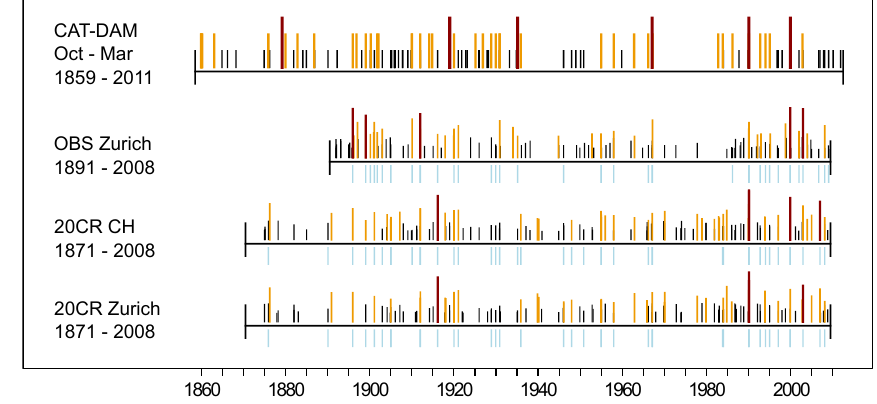
Figure 7. Top to bottom: classified winter (October to March) storms from the damage-based data set (CAT-DAM); classified windstorm days from wind observations at Zurich station (OBS Zurich), from 20CR CH (six grid points over Switzerland) and from 20CR Zurich (grid point near Zurich). Horizontal and vertical bars are as in Fig. 3; in addition, the bar lengths of the wind series indicate scaled wind